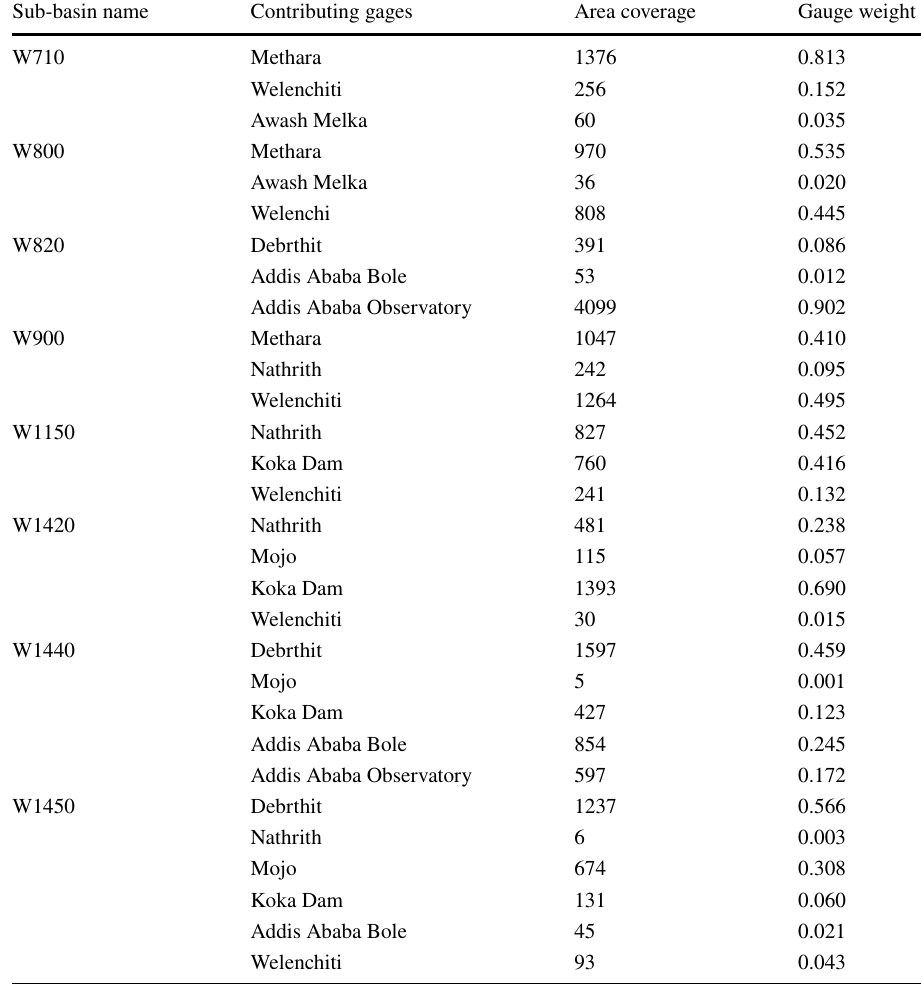
Table 3 Sub-basins and rainfall stations with their gauge weights